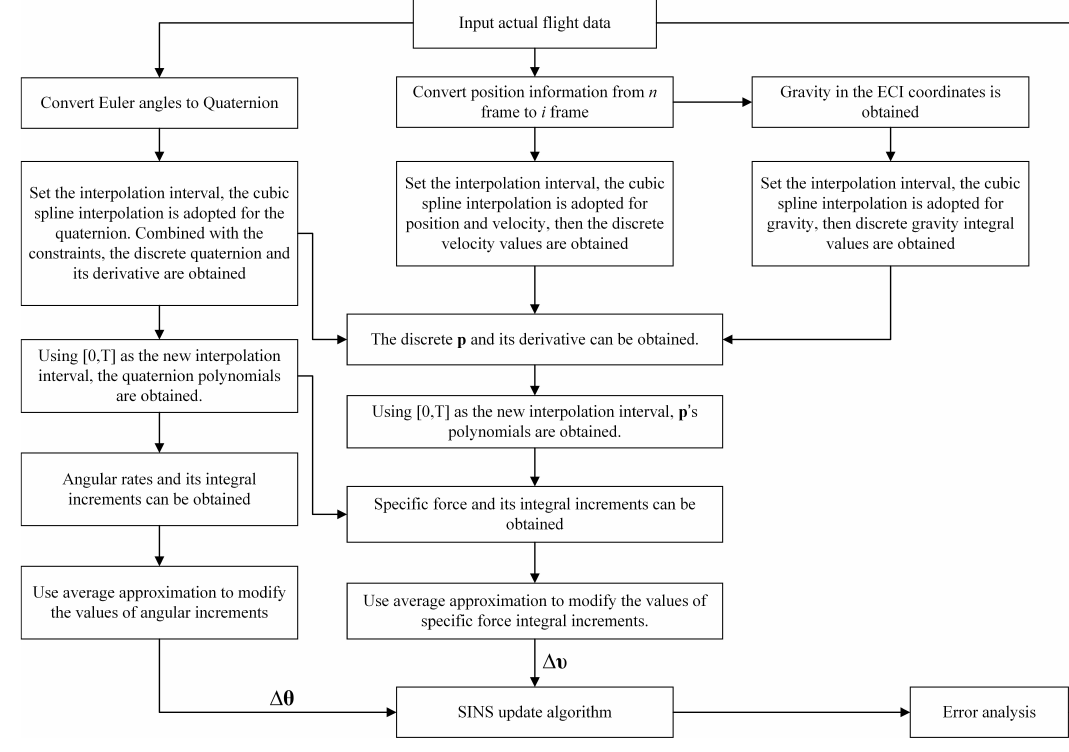
Figure 1. Algorithm flow